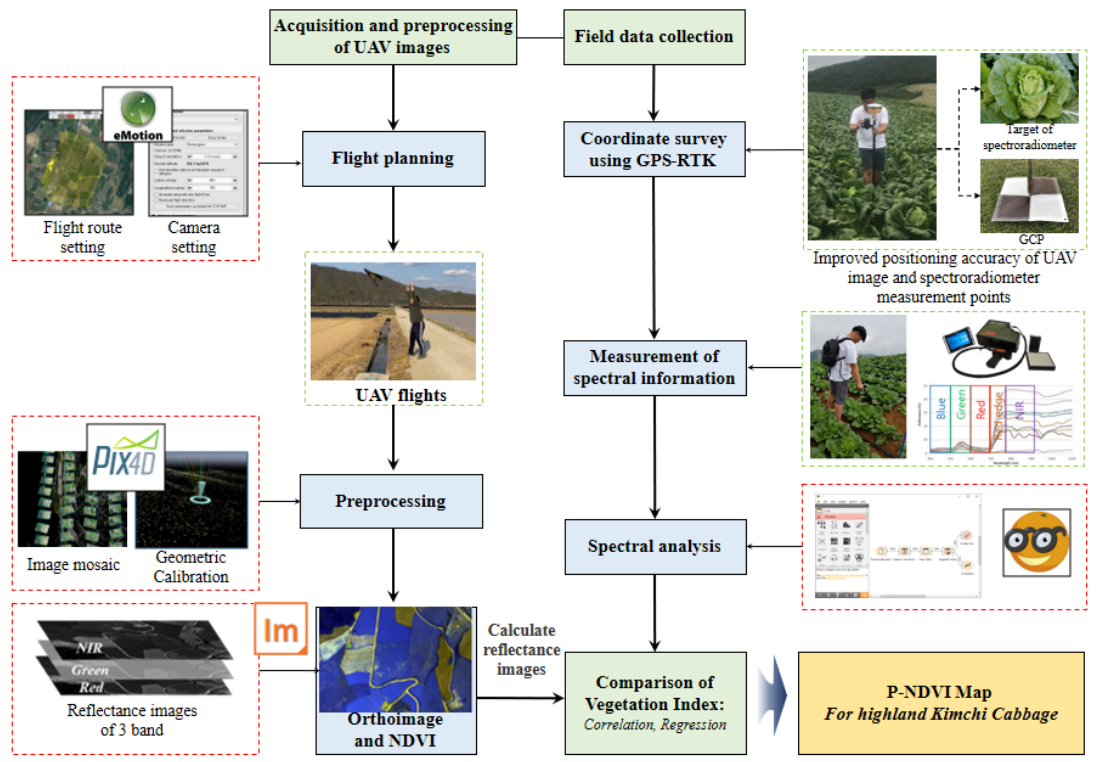
Figure 5. Flowchart of the precise normalized distribution vegetation index (p-NDVI) map calculation process using UAV observations, a spectroradiometer, and global positioning system–real-time kinematic (GPS–RTK)